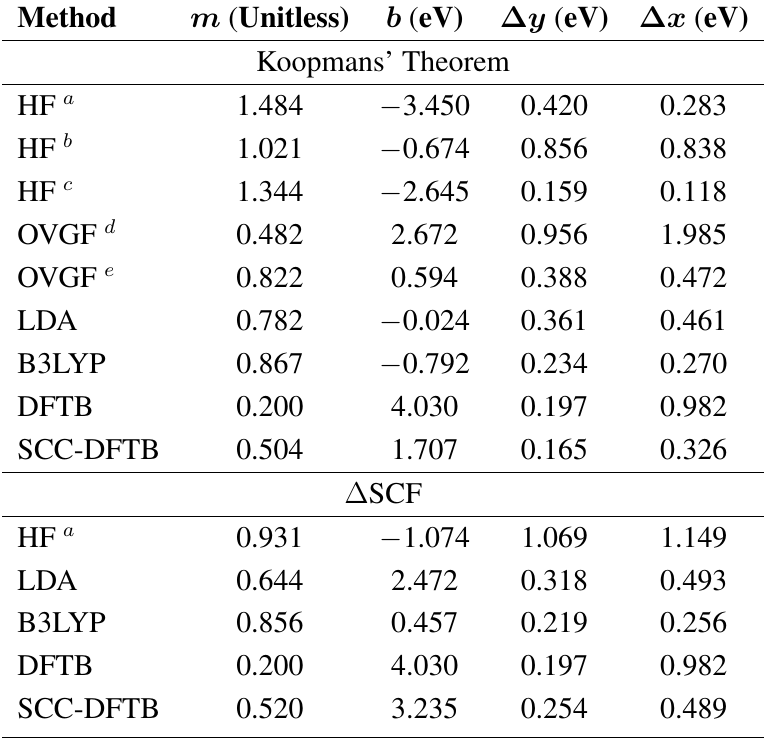
Table 7. Fitting data for the first IPs of the medium-sized BDS molecules: y = mx + b , where x is the GW IP and y is another theoretical IP, both in eV. HF, Hartree–Fock; OVGF, outer valence Green’s function; LDA, local density approximation; DFTB, density-functional tight binding (without self-consistent charge); SCC-DFTB, self-consistent charge